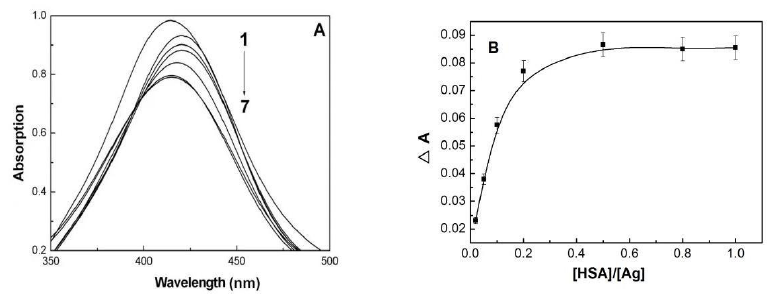
Figure 5. ( A ) The localized surface plasma resonance absorption of different concentrations of HSA with AgNPs, C(AgNPs) = 1.0 × 10 − 4 M, 1–7: [HSA]/[AgNPs] = 0, 1:50, 1:40, 1:30, 1:20, 1:10, 1:1; ( B ) The relationship between the change of absorption intensity ( (cid:52) A) and